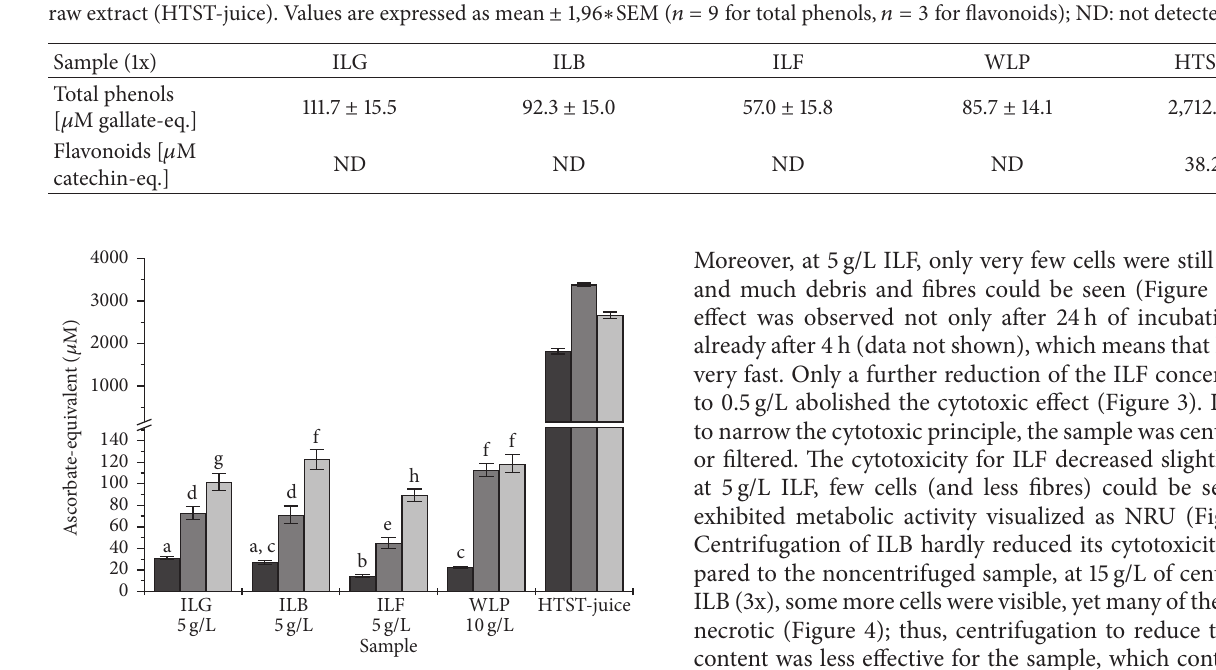
Table 2: Concentration of total phenols and flavonoids in different commercial starting products at the concentration 1x compared to the